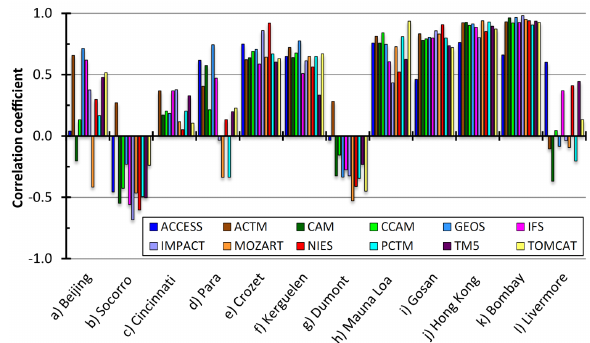
Figure 11. Correlation coe ffi cients between simulated and observed monthly mean surface 222 Rn 1004 Fig. 11. Correlation coefficients between simulated and observed concentration at continental (a–d), remote island (e–h) and coastal (i–l) sites. 1005 monthly mean surface 222 Rn concentration at continental (a–d) , re- 1006 mote island (e–h) and coastal (i–l)